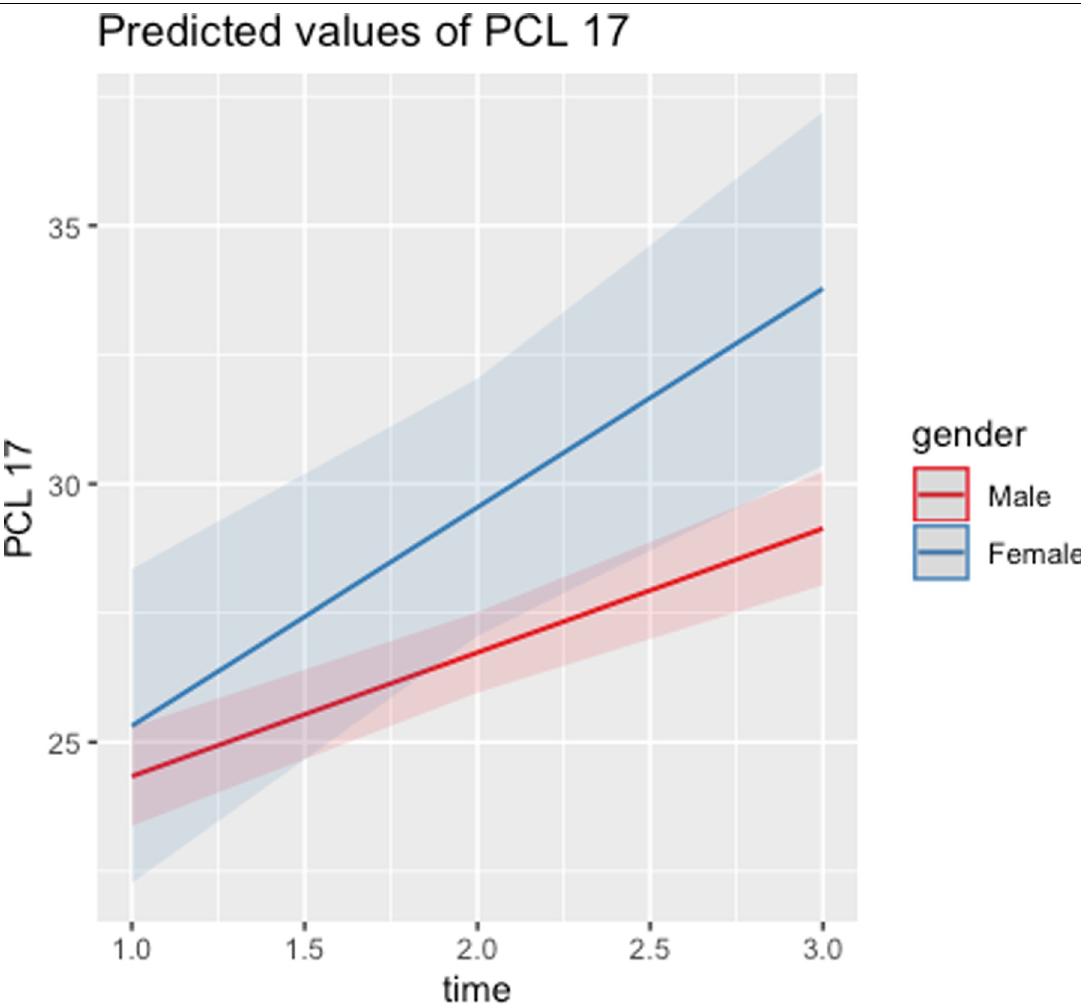
Fig 1. Predicted values of PCL-17 across time: Males vs.